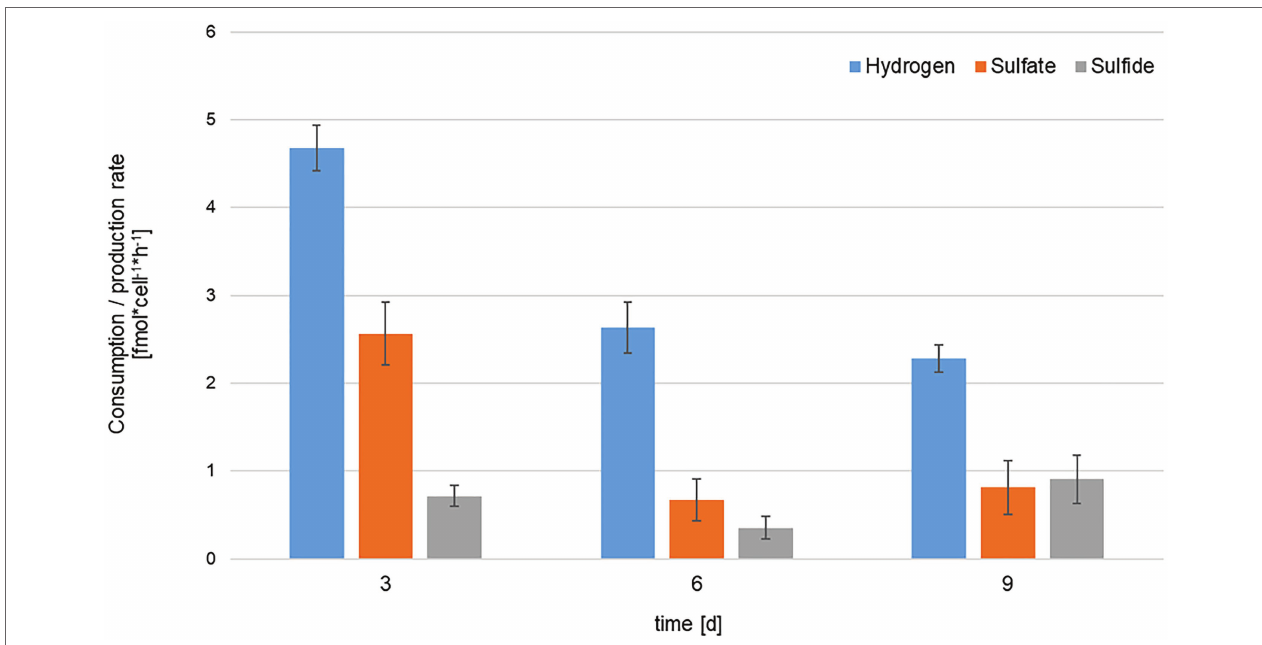
FIGURE 7 | Comparison of hydrogen consumption (blue), sulfate consumption (orange) and sulfide production (gray) rates of KaireiS1 at three different time points. Rates are normalized to consumption/production per cell per hour and error bars indicate the standard deviations from three independent